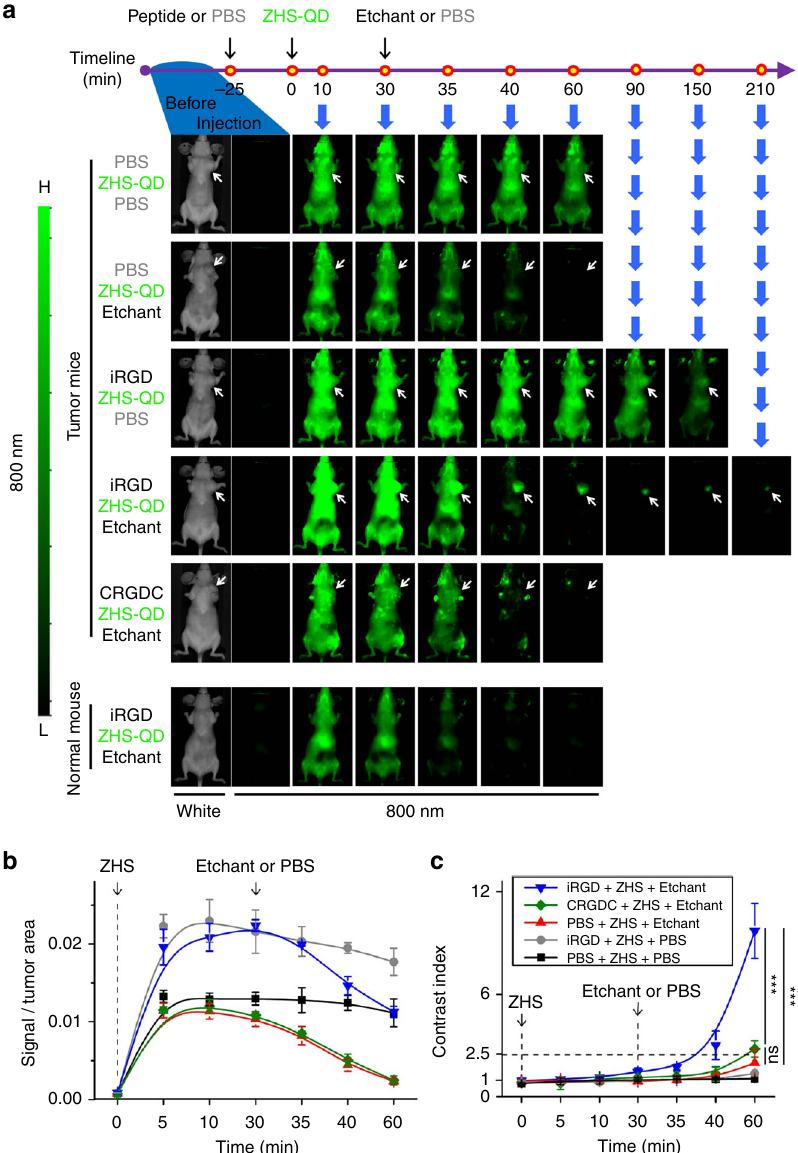
Fig. 3 Time-dependent in vivo breast tumor imaging with etchable ZHS-QDs. Normal mice and mice bearing orthotopic MCF10CA1a human breast tumors received an intravenous injection of iRGD, CRGDC, or PBS before intravenous ZHS-QD injection. Ag-TS or PBS was given intraperitoneally. n = 4 per group. a The mice were anesthetized and imaged from the ventral side with a Li-Cor Pearl imager under 800 nm channel at the indicated time points. Arrows , tumors. b NIR signals in the tumor per unit area plotted against time. c Time-dependent changes of CI in the tumor area. Statistics, two-way analysis of variance; error bars , SEM; ns, not signi fi cant; *** P <